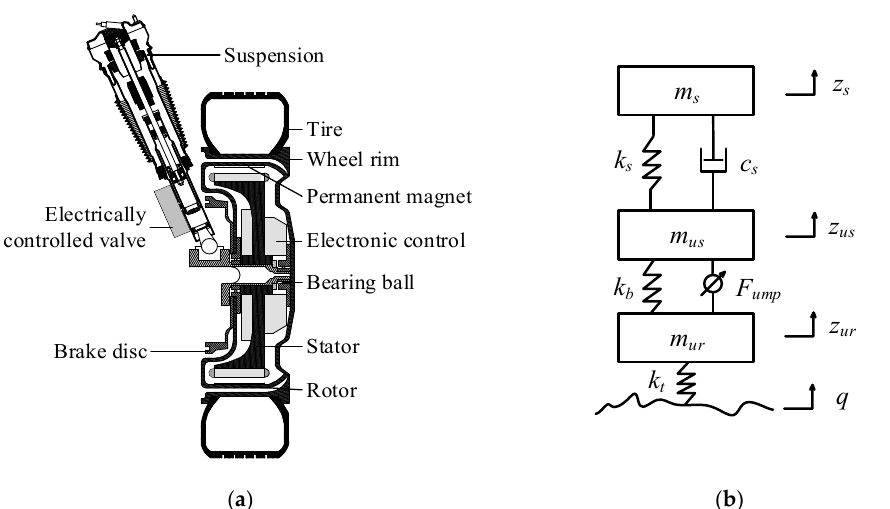
Figure 2. Hub-motor electric vehicle (HM-EV) system: ( a ) physical structure; ( b ) equivalent model.